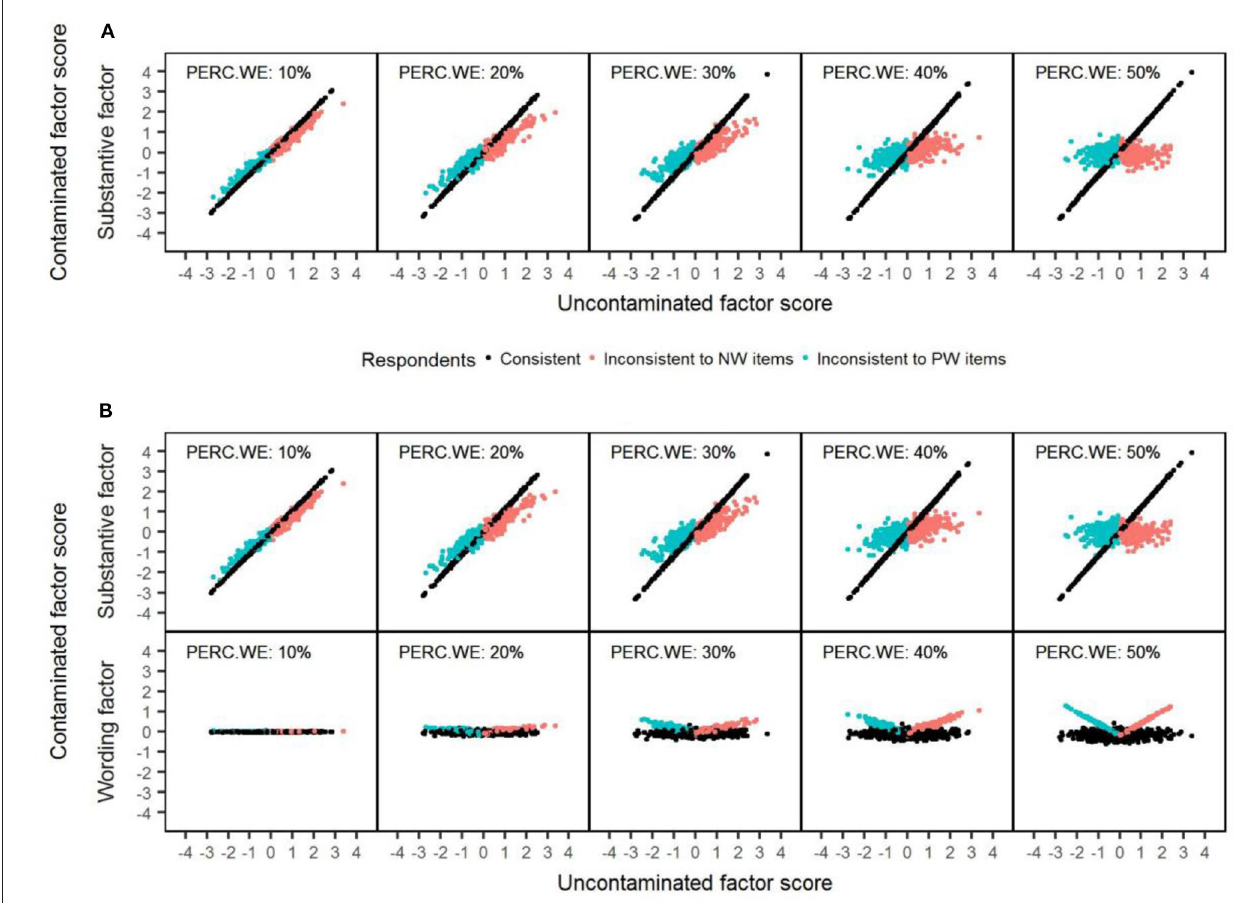
FIGURE 7 | Example of recovery of the substantive factor scores with the 1F and RIIFA models in the presence of item verification difficulty. The data represented corresponds to simulated unidimensional data sets with 1,000 respondents and 20 variables. 1F, unidimensional model with one substantive factor; RIIFA, random intercept item factor analysis model with one substantive factor and one wording method factor; PERC.WE, amount of wording effect; NW, negatively worded; PW, positively worded. (A) 1F model. (B) RIIFA